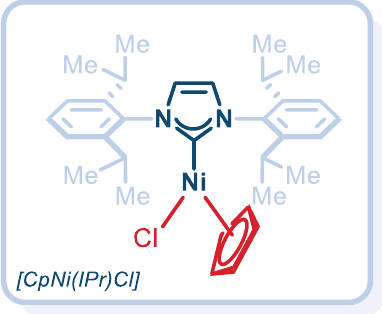
Figure 2. Structure of the air- and moisture-stable, well-defined, half-sandwich, cyclopentadienyl [CpNi(IPr)Cl] complex.